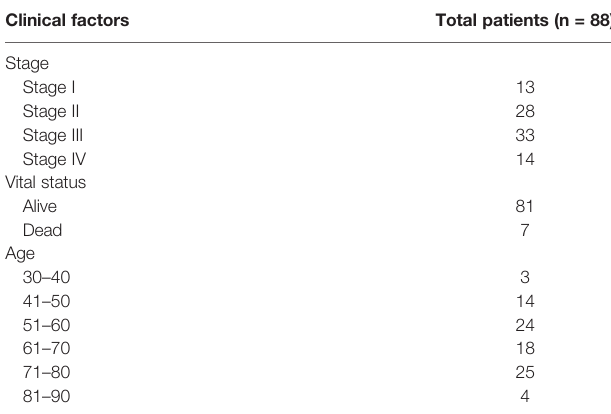
TABLE 1 | Clinical information of rectal cancer samples from The Cancer Genome Atlas (TCGA) used for